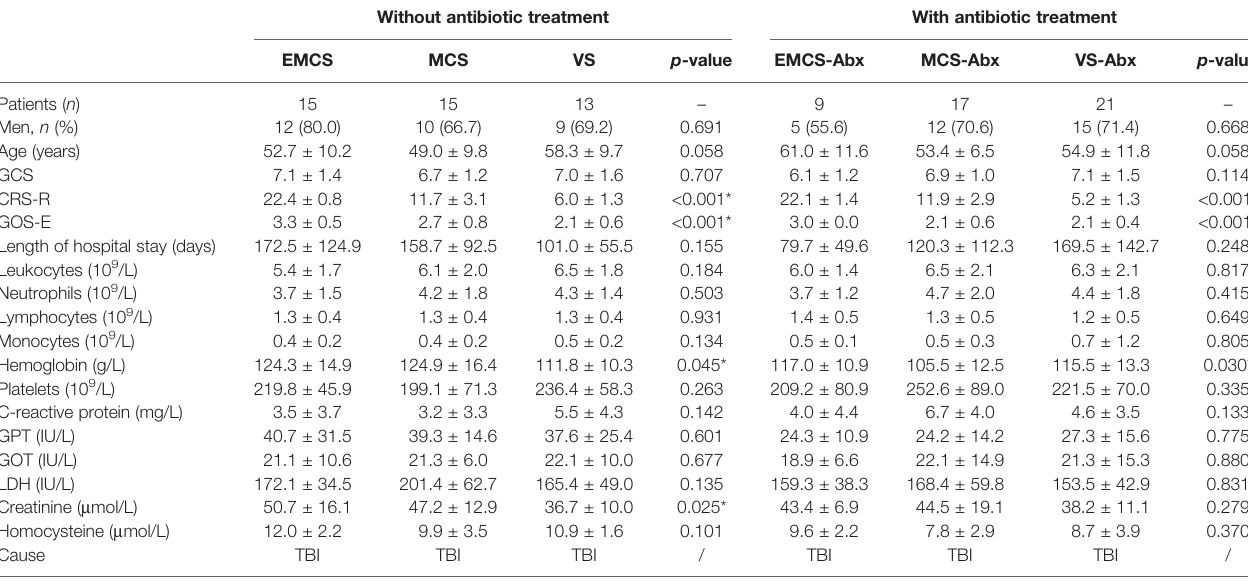
TABLE 1 | Clinical characteristics of the patients in this study. Without antibiotic treatment With antibiotic